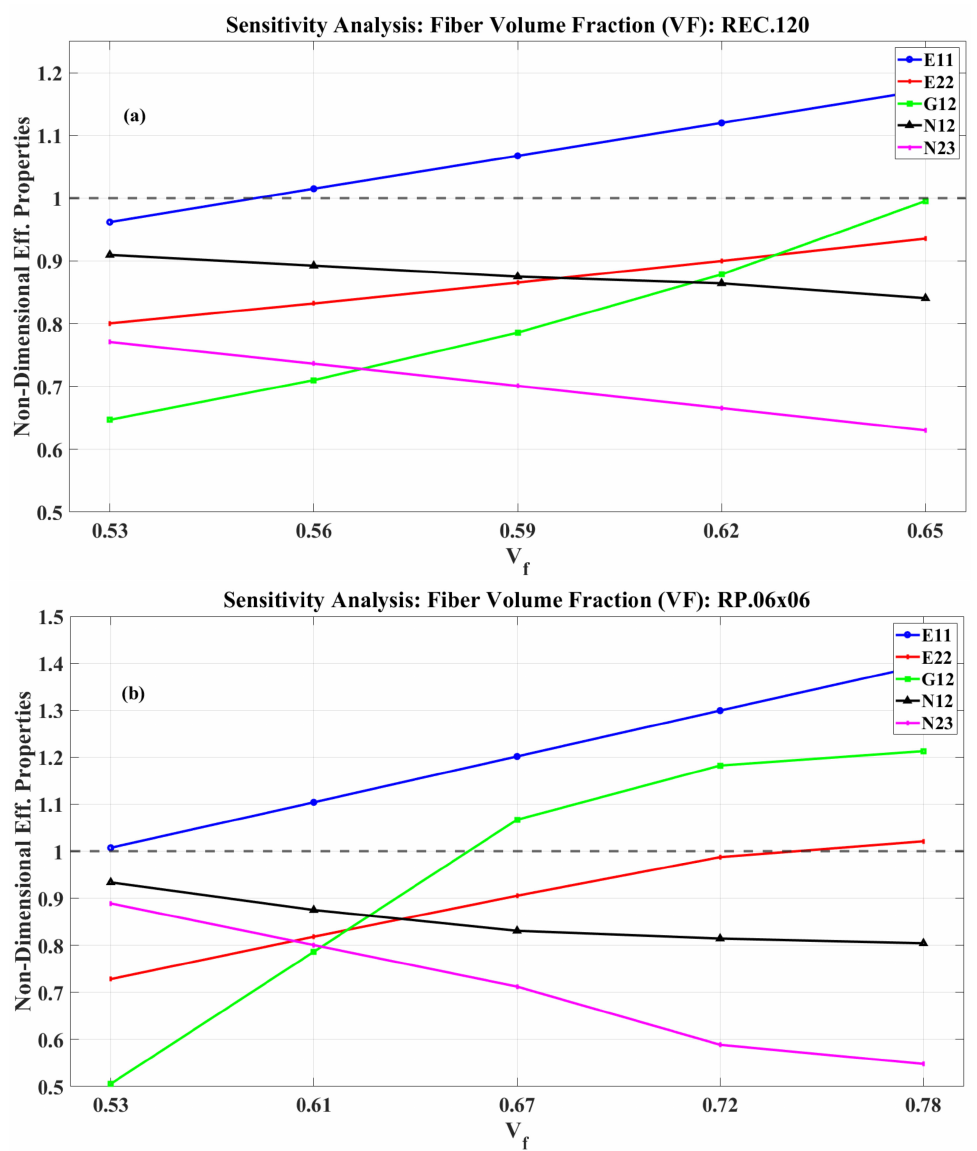
Figure 8. Nondimensional predicted effective properties as a function of fiber volume fraction